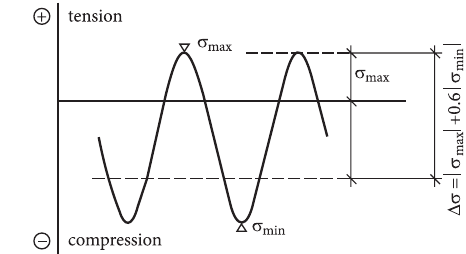
Fig. 11. Stress reduction of the compressive portion of the stress range according to EN